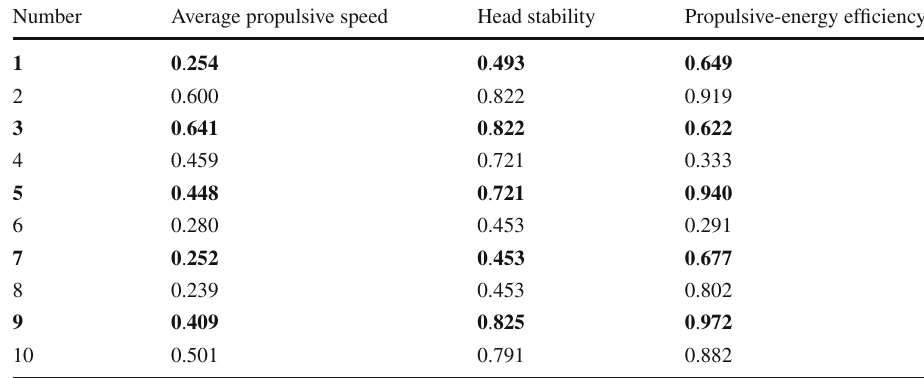
Number Average propulsive speed Head stability Propulsive-energy efficiency non-dominated solutions obtained by our proposed model 1 0 . 254 0 . 493 0 . 649 with the MOWOA in three objectives